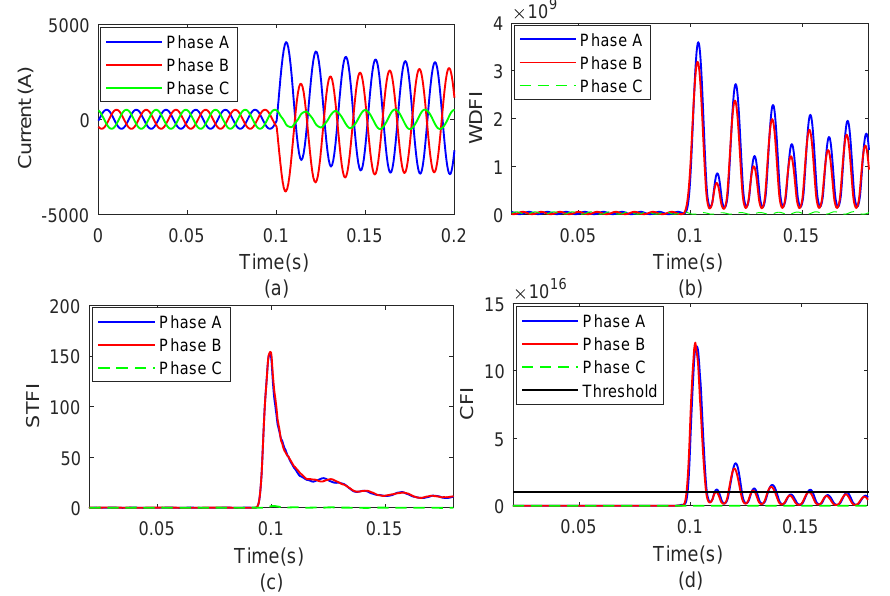
Figure 6. Detection of fault incident between phase A and phase B ( a ) current waveform ( b ) WDFI ( c ) STFI ( d )